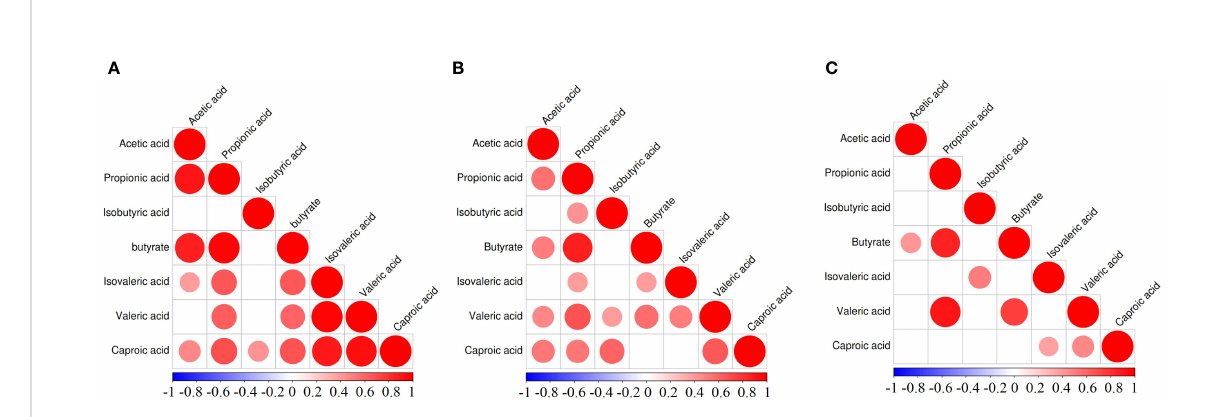
FIGURE 3 Correlation heatmap of different SCFAs in pregnancy complication groups. (A) GDM group, (B) PE group, (C) ICP group. When the linear relationship of the two metabolites is enhanced, the correlation coef fi cient tends to 1 or − 1. The correlation is a maximum of 1, a complete positive correlation (red), a correlation of − 1, and a complete negative correlation (blue). The white/clear color on the scale bar indicates no